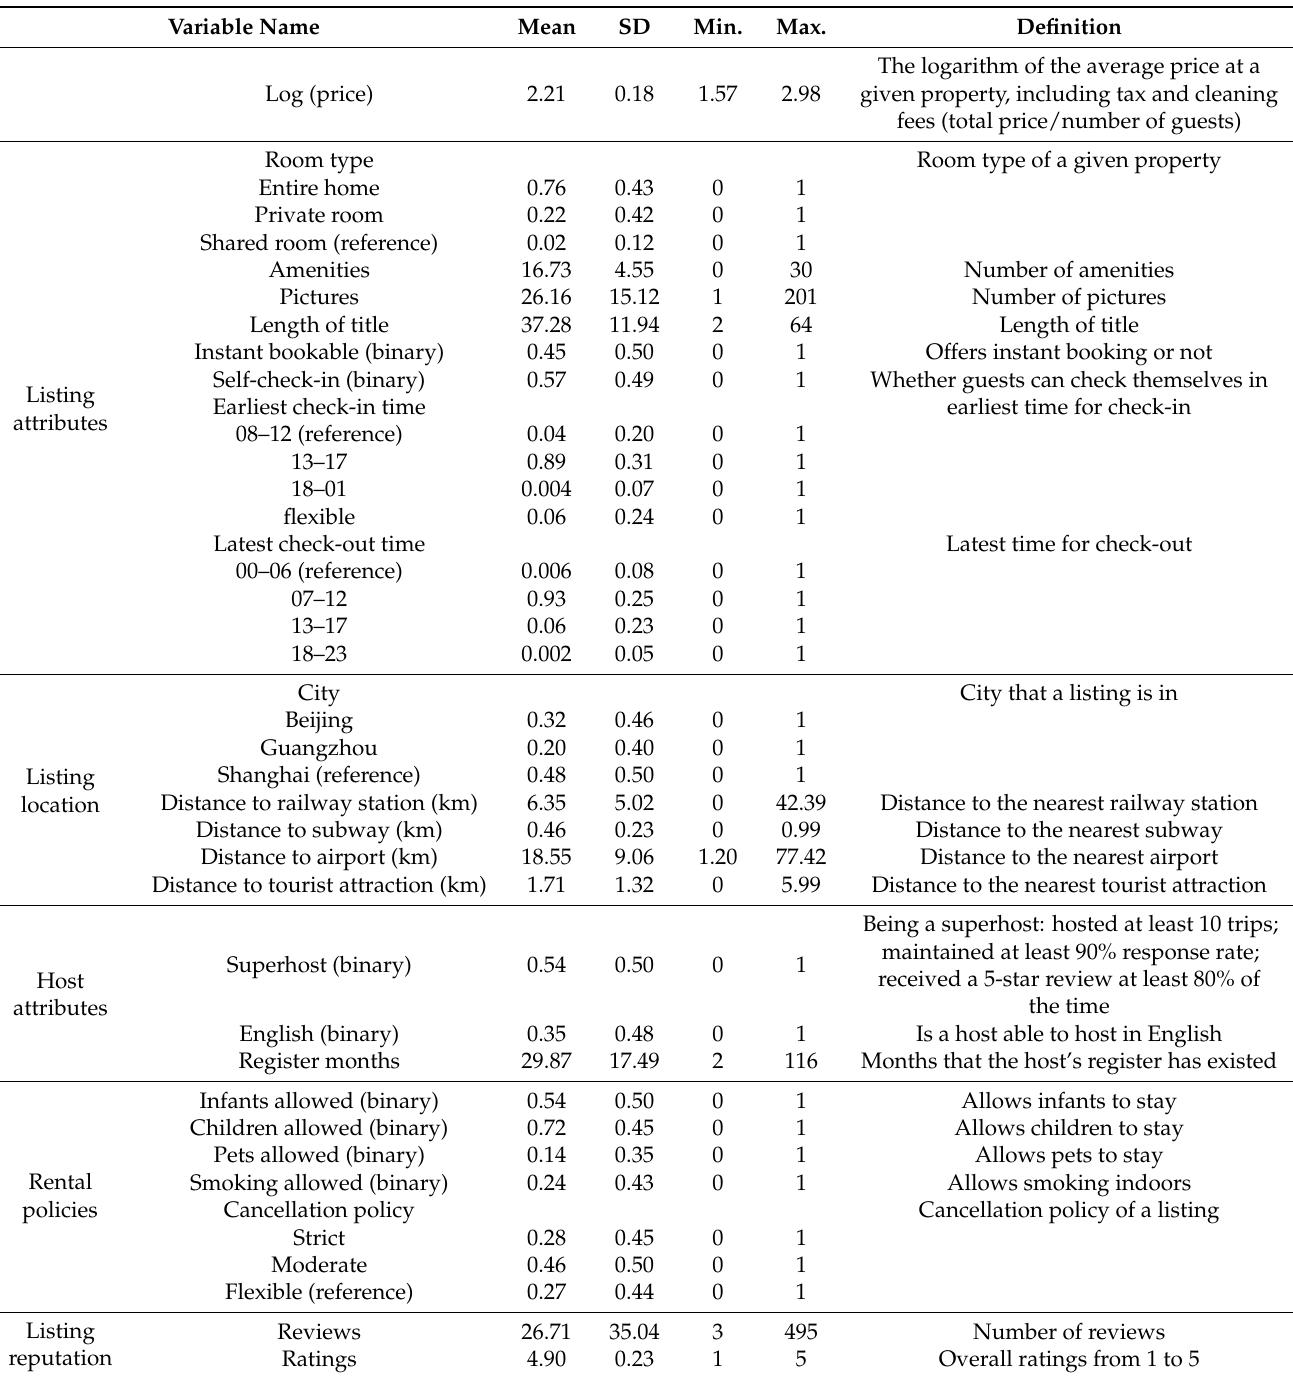
Table 2. Variable